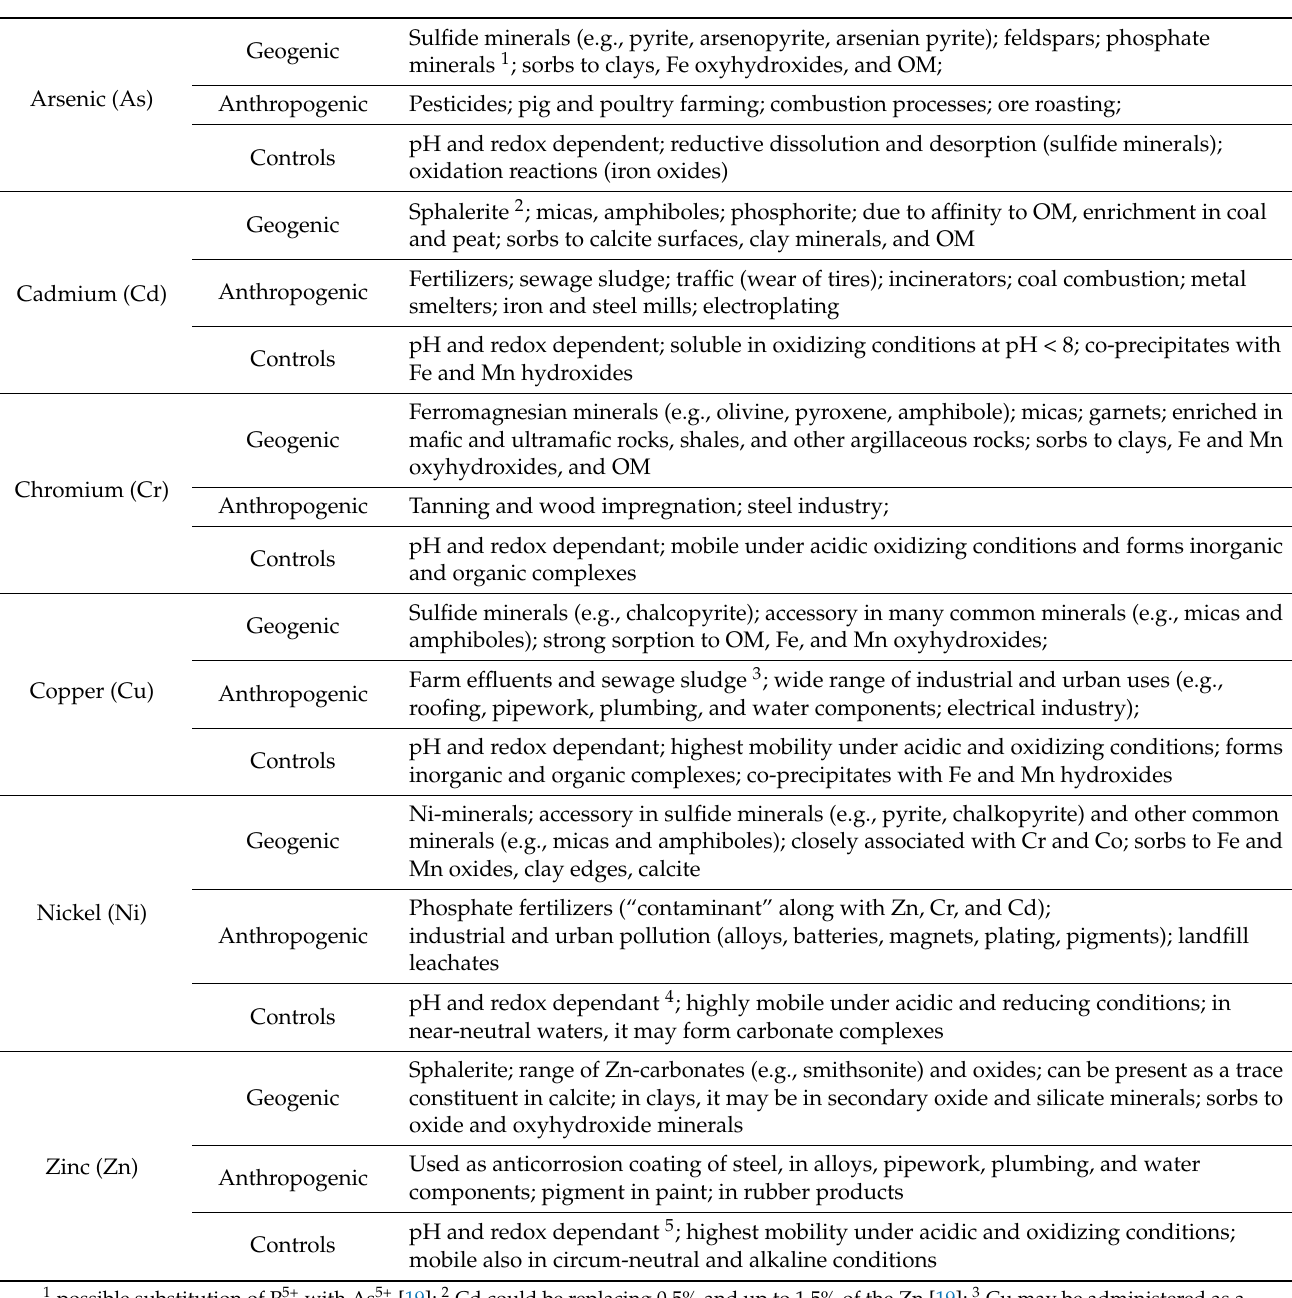
Table A1. Geogenic and anthropogenic sources and geochemical controls (summarized from [5,19]). Sulfide minerals (e.g., pyrite, arsenopyrite, arsenian pyrite); feldspars; phosphate Geogenic minerals 1 ; sorbs to clays, Fe oxyhydroxides, and OM; Arsenic (As) Anthropogenic Pesticides; pig and poultry farming; combustion processes; ore roasting;